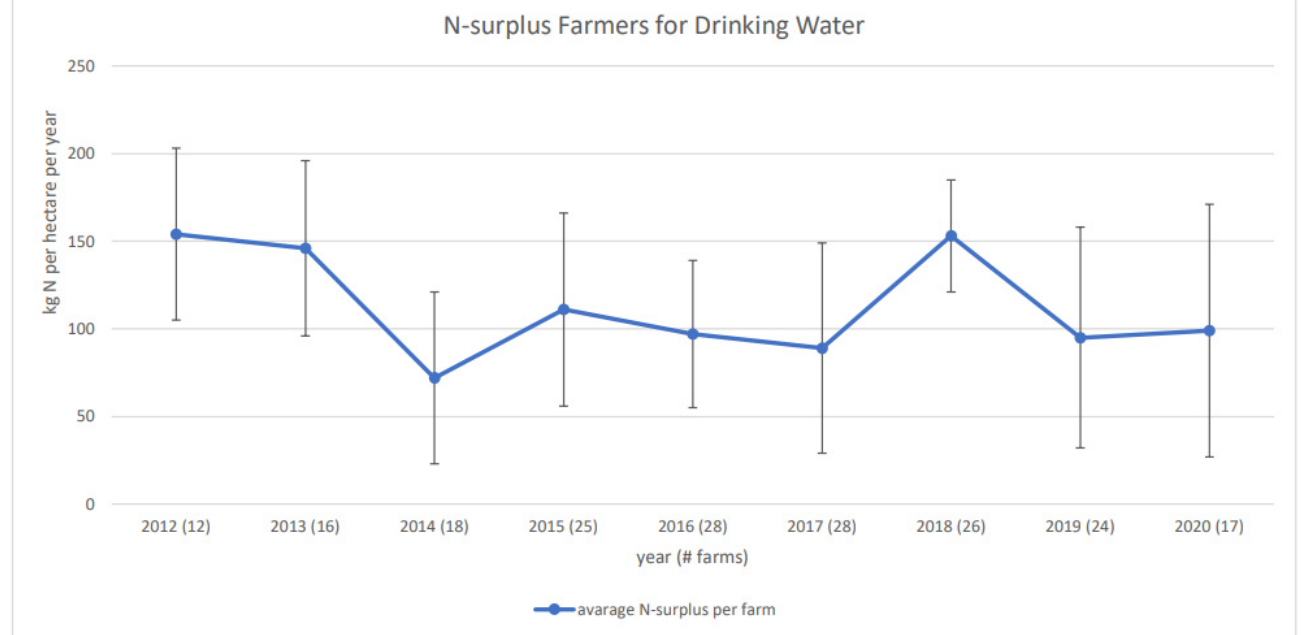
Figure 1. Dynamics of the N-surplus on the whole farm soil balance, average for all pilot farms per year.